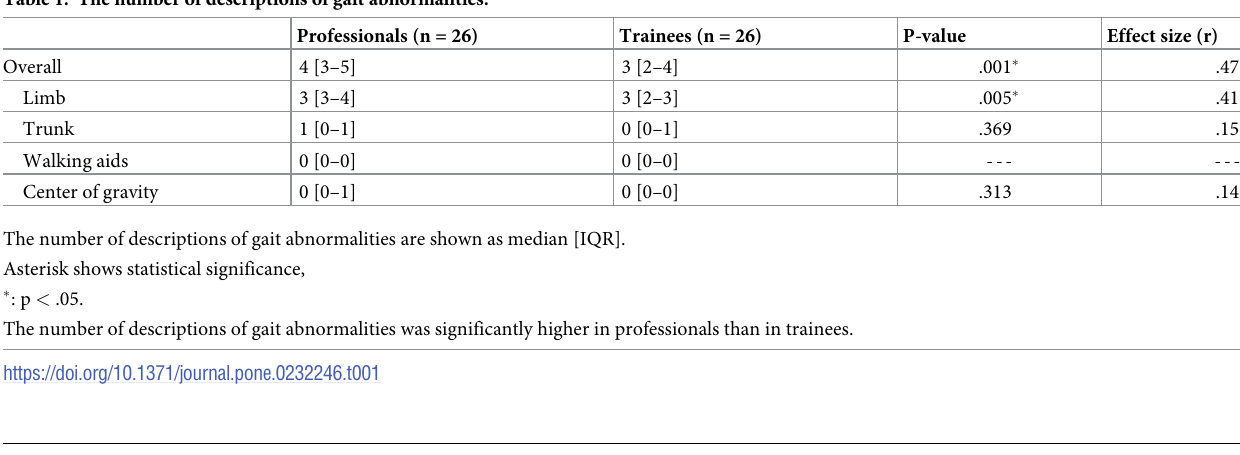
Table 1. The number of descriptions of gait